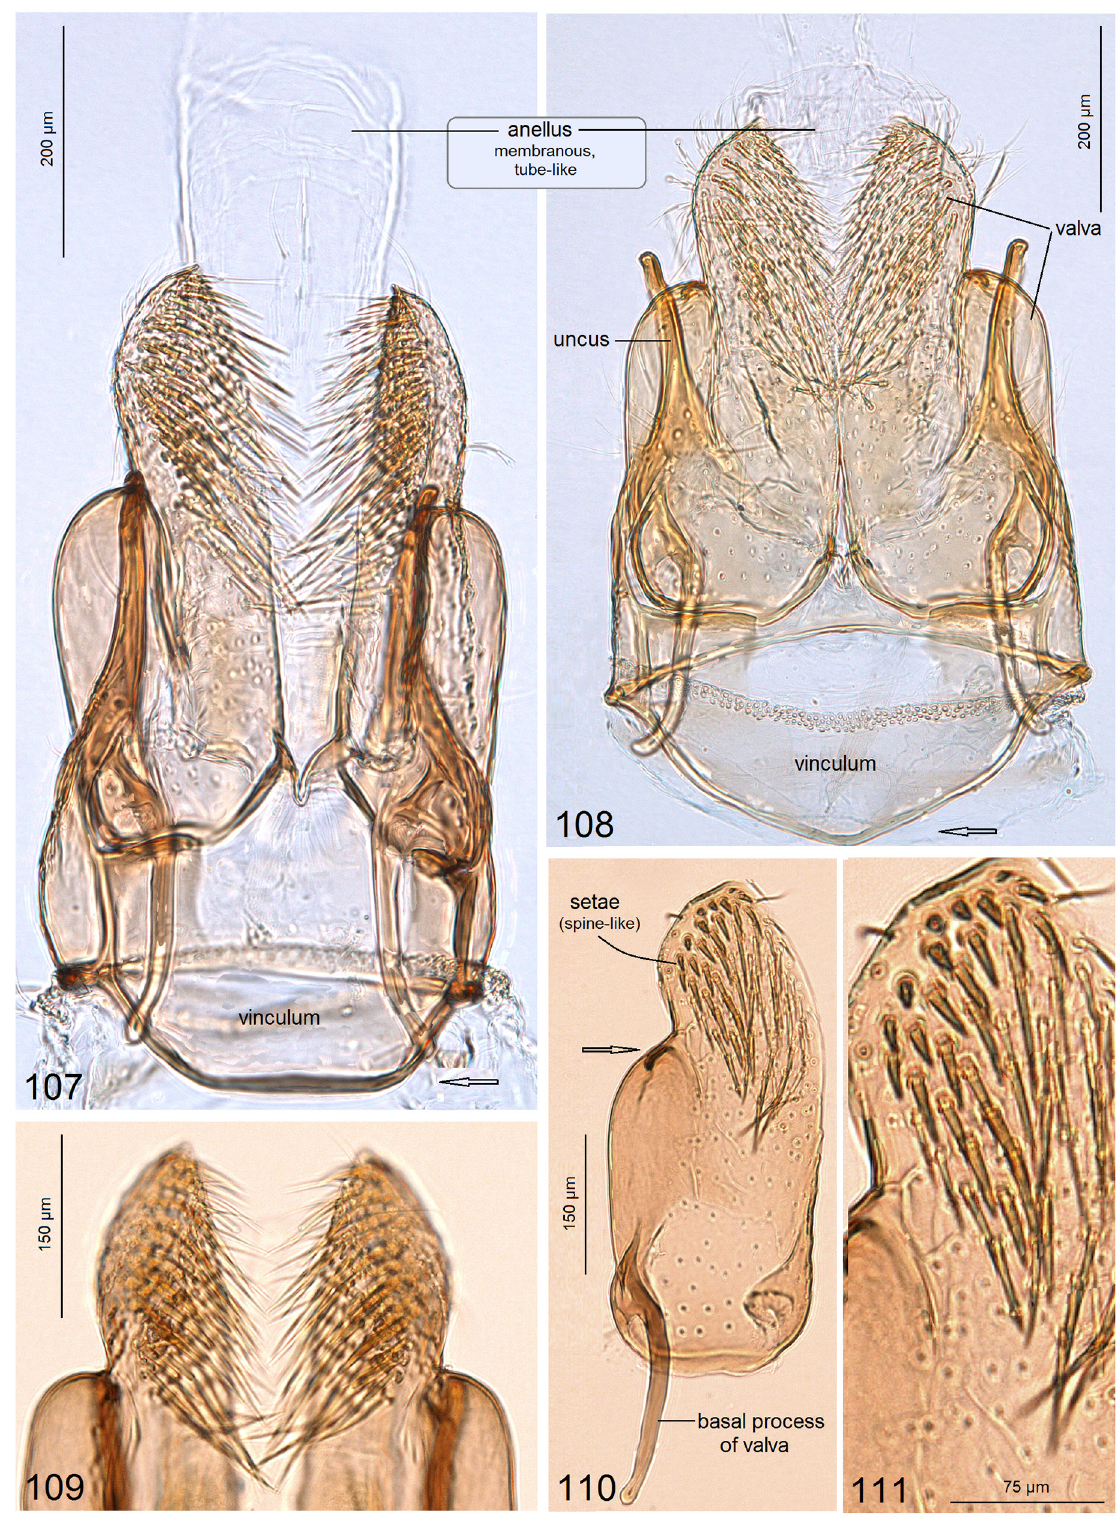
Figs 107–111. Male genitalia of Paratischeria tubifex Diškus & Stonis sp. nov. (NHMUK). 107 . Capsule, with phallus removed, holotype (genitalia slide no. 010316168). 108 . Capsule with phallus removed, paratype (genitalia slide no. 010316171). 109 . Apical parts of valvae, paratype (genitalia slide no. 010316172). 110–111 . Valva, paratype (genitalia slide no.